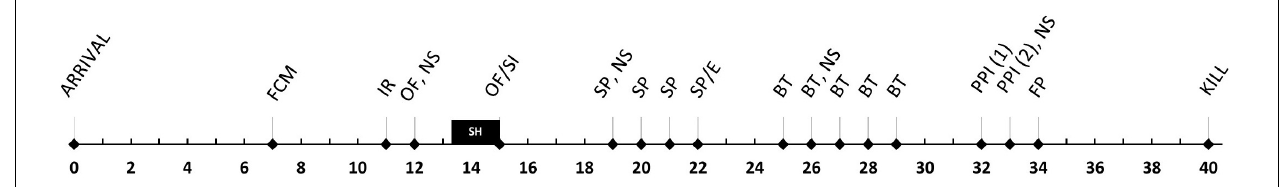
FIGURE 1 | Timeline. Numbers indicate the day of the experiment. FCM, fecal corticosterone metabolites; IR, irwin test; OF, open field; NS, nest score; SH, single housing; SI, social interaction; SP, saccharin preference; E, ethogram; BT, burrowing test; PPI, prepulse inhibition; P, footprint